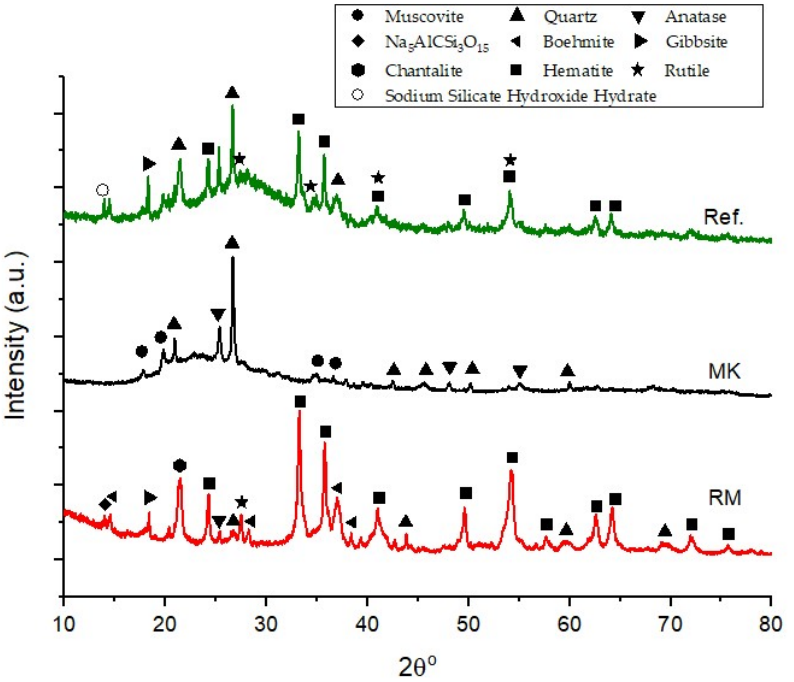
Figure 2. XRD patterns of the raw materials and red mud geopolymer (reference) prepared without a foaming agent or surfactant.